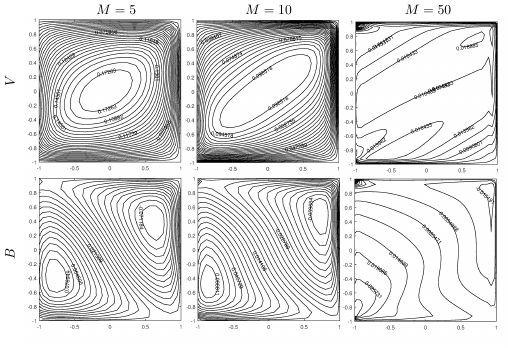
Figure 7. Velocity and induced magnetic field from direct problem, π , α = 0 . 2 , c = 0 . 3. β = 4